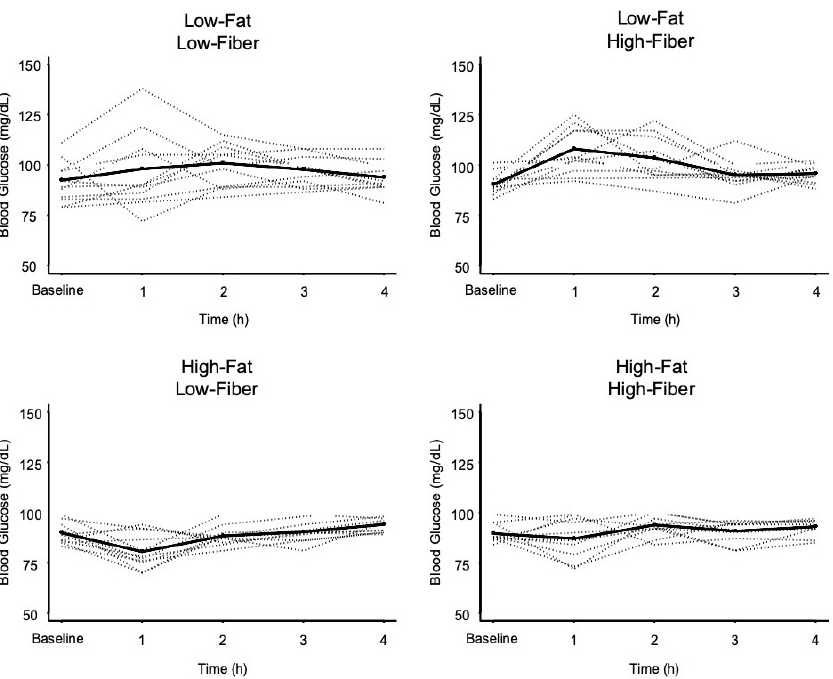
Figure 1. Blood glucose concentrations over time in response to the four meals. Dashed lines represent individual subject responses. Solid line represents mean response for all subjects. See text and Table 3 for statistical comparisons. Table 3. Blood glucose changes from baseline to 1 h postprandial: comparison between meals.